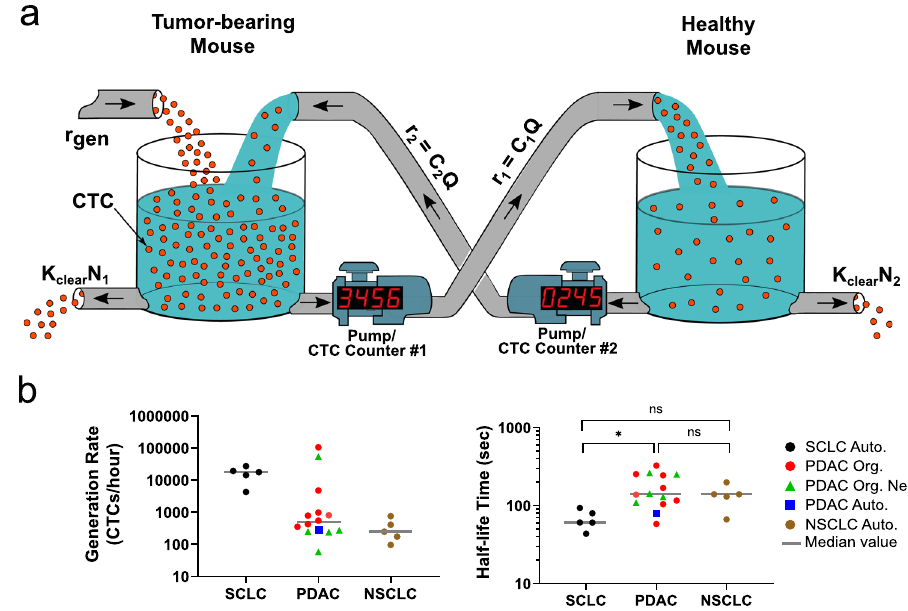
Fig. 2 An analytical model for extracting CTC generation rate and half-life time in blood. a A visual representation of the relevant parameters of the blood exchange technique to solve for the generation rate and the half-life time of CTCs. The circulatory system of each mouse is represented as a well- mixed container of red spheres (CTCs). In the TBM (left tank) CTCs enter the circulation from the tumor microenvironment at a rate equal to r gen . CTC clearance out of the circulation is represented by a hole at the bottom of each container with a clearance rate of K clear × N . Pumps with counters represent the CTC counter systems and their peristaltic pumps that transfer the CTC-containing blood at rates equal to C × Q . r : rate of CTC transfer. C : concentration. Q : fl ow rate. K clear : fi rst-order clearance coef fi cient. N : total number of CTCs in each mouse. b Scatter plots for the calculated CTC generation rates and the half-life times of each of the different small-cell lung cancer (SCLC), pancreatic ductal adenocarcinoma (PDAC), and non-small- cell lung cancer (NSCLC) blood-exchange experiments (* p < 0.05 ( p = 0.0136), Kruskal − Wallis nonparametric test with Dunn ’ s sample pairs analysis). For SCLC, n = 5 biologically independent experiments. For PDAC, n = 8, 5, and 1 biologically independent experiments, respectively, for Org, Org. Neo., and Auto. For NSCLC, n = 5 biologically independent experiments. Auto autochthonous. Org. organoid. Neo neoantigen. ns not signi fi